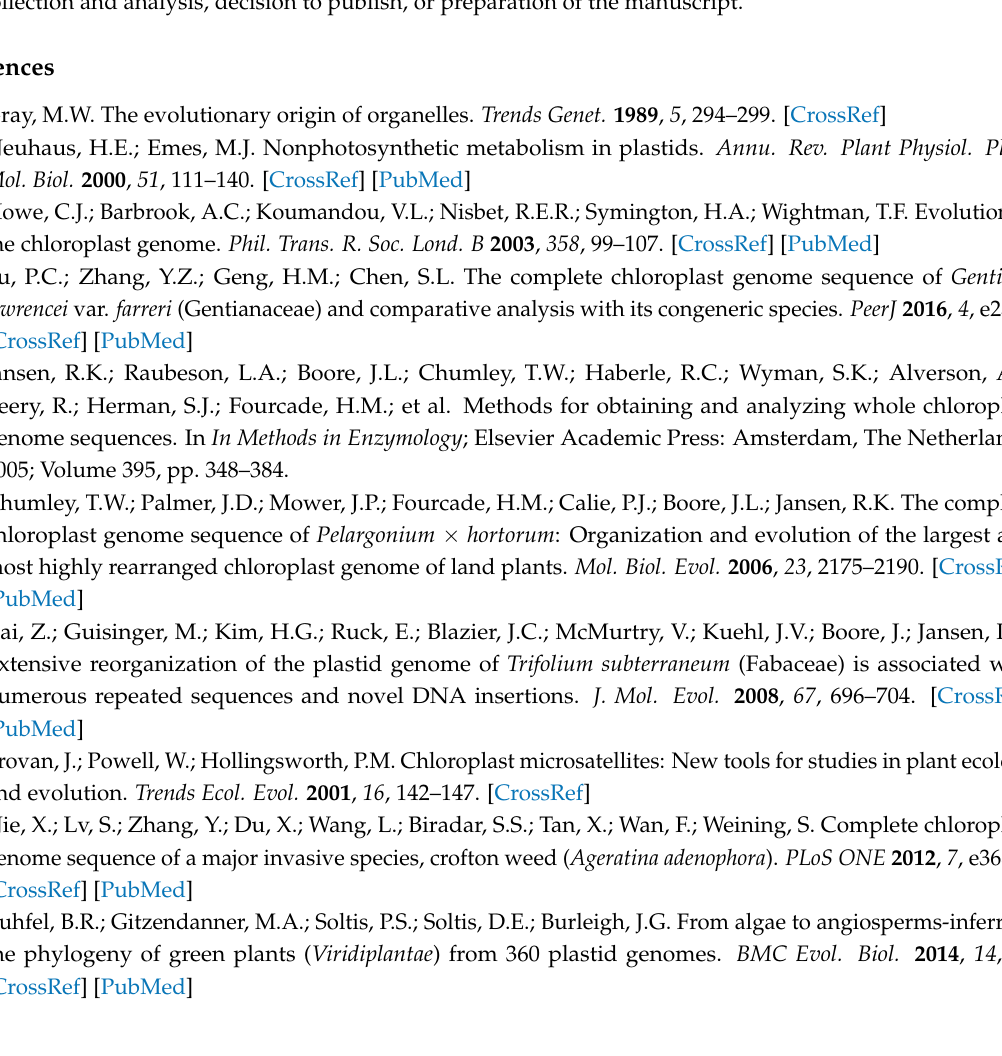
Table S1: The SSR abundance and composition in broomcorn millet and other five Panicoideae species; Table S2: The potential SSR marker developed for Panicoideae species